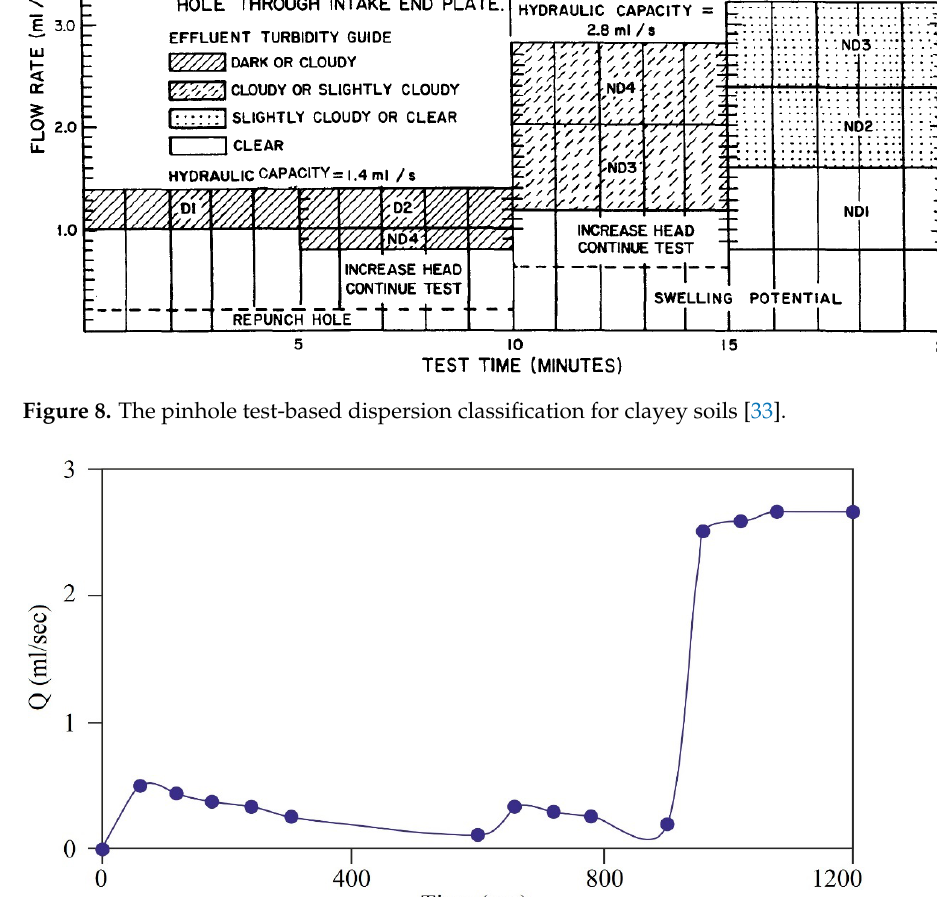
Figure 10. Variation of water flow in a clayey soil sample with additives. Although the pinhole test’s results indicate that Bentonite with the specified weight percentage used did not negatively affect the clayey soil, the double ‐ hydrometric test detected divergence in admixture (clay + 10% Bentonite). The experiment variation graph